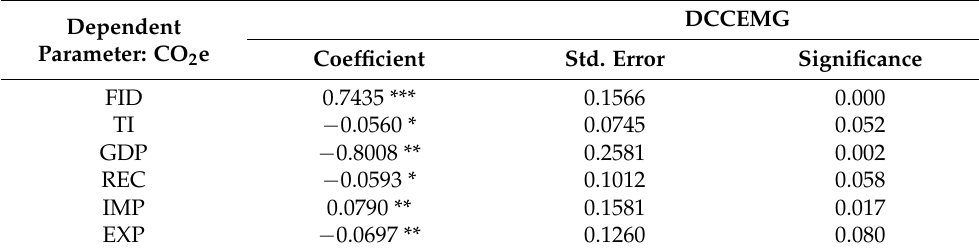
Table 8. Shows results obtained from DCCEMG model.